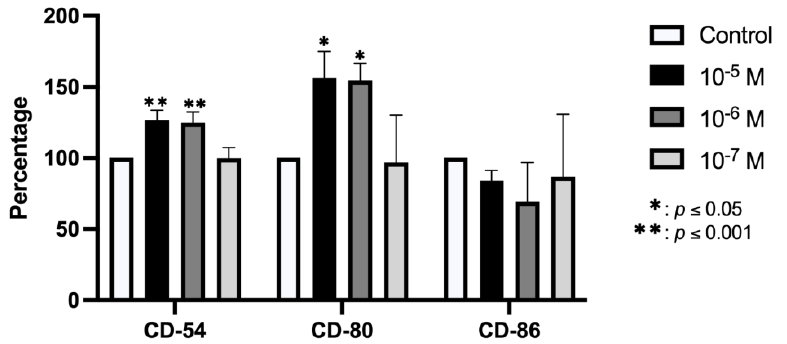
Figure 1. Effect of BPA at different doses (10 −5 , 10 −6 , or 10 −7 M) on osteoblast growth and cellular viability in primary cell lines after 24 h of incubation. ( A ) Effect on cellular proliferation. ( B ) Effect on induction of apoptosis/necrosis. Data are expressed as means ± standard deviation. Significant differences * p < 0.05; ** p < 0.001.